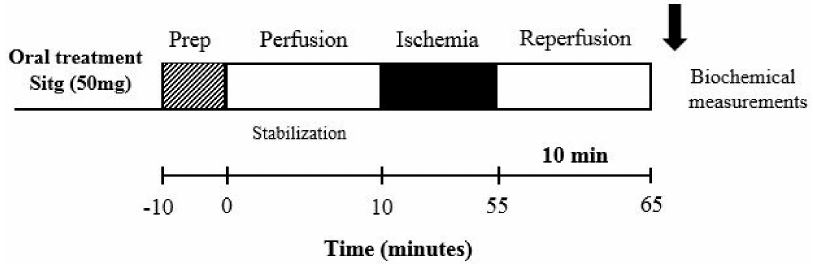
Figure 13. Schematic diagram clarifying the ischemia-reperfusion (I/R) protocol used with brief reperfusion time (10 min) for the purpose of biochemical measurements in experiment